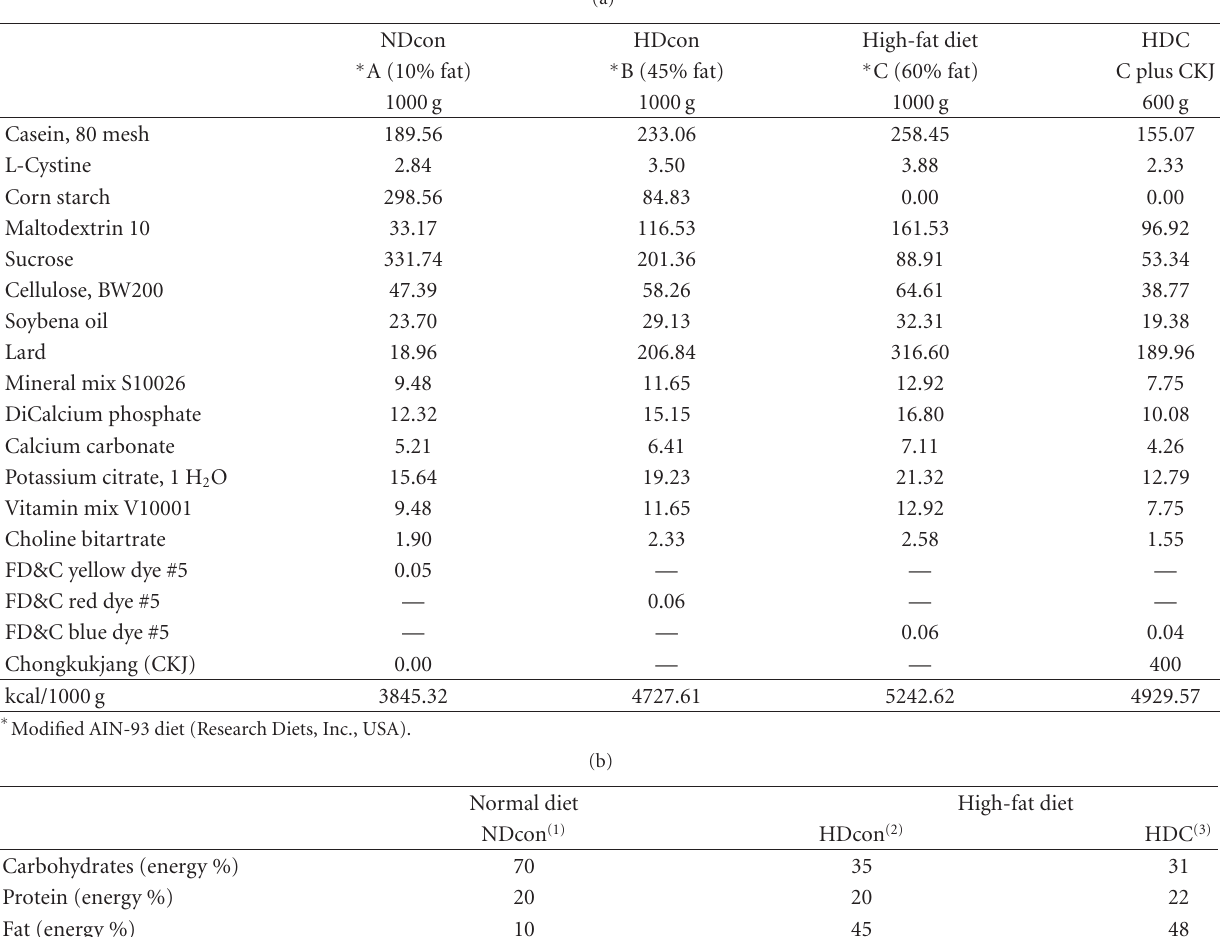
Table 1: Composition of experimental